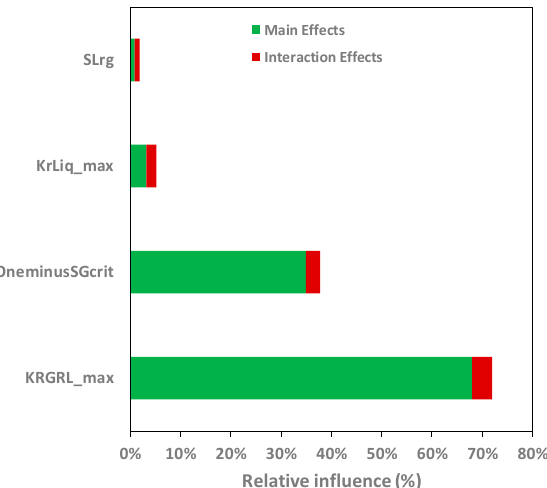
Figure 10. The optimal history matched bottom hole pressure at the injection well HI during the single-phase brine and two-phase CO 2 -brine injection periods.